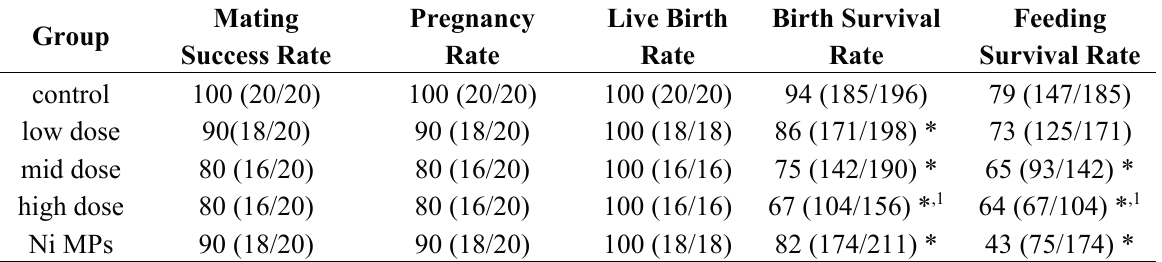
Table 3. Effects of Ni NPs on the rats reproductive index (%).